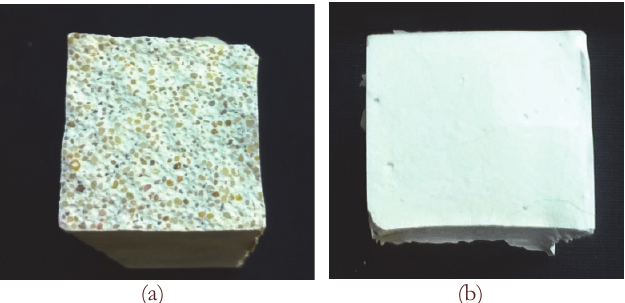
Figure 12: Cross section of typical specimens made of (a) mortar and (b) cement paste.